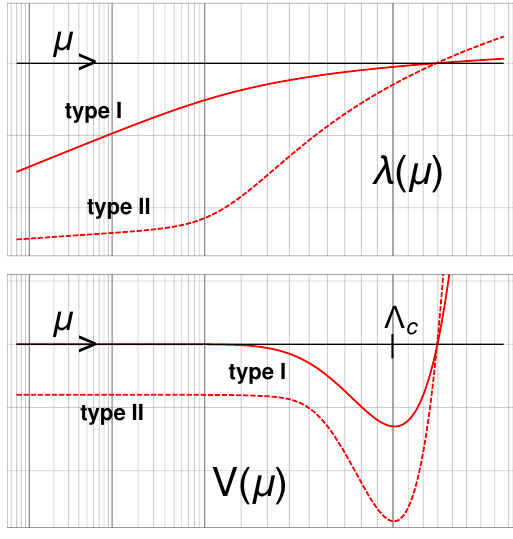
Figure 1 . Behavior of the quartic coupling (upper plot) and e(cid:11)ective potential for the dilaton (lower plot) as a function of (cid:22) for models of type I and type